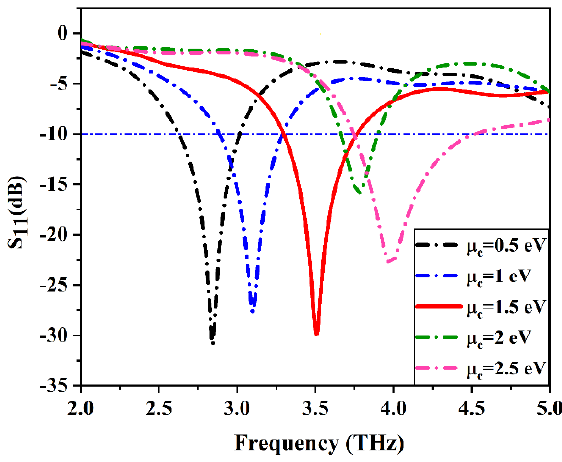
Figure 7 . |S 11 | parameters of the graphene plasmonic antenna for different chemical potential . Figure 7. |S 11 | parameters of the graphene plasmonic antenna for different chemical